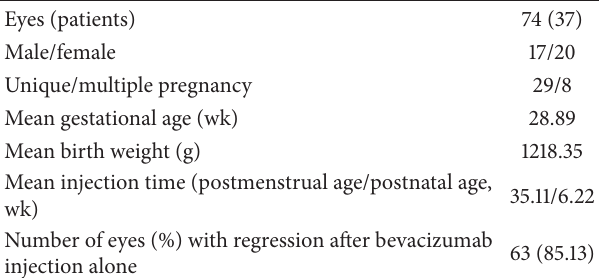
Table 1: Demographic and clinical characteristics of the premature infants who received intravitreal bevacizumab as primary therapy for ROP.